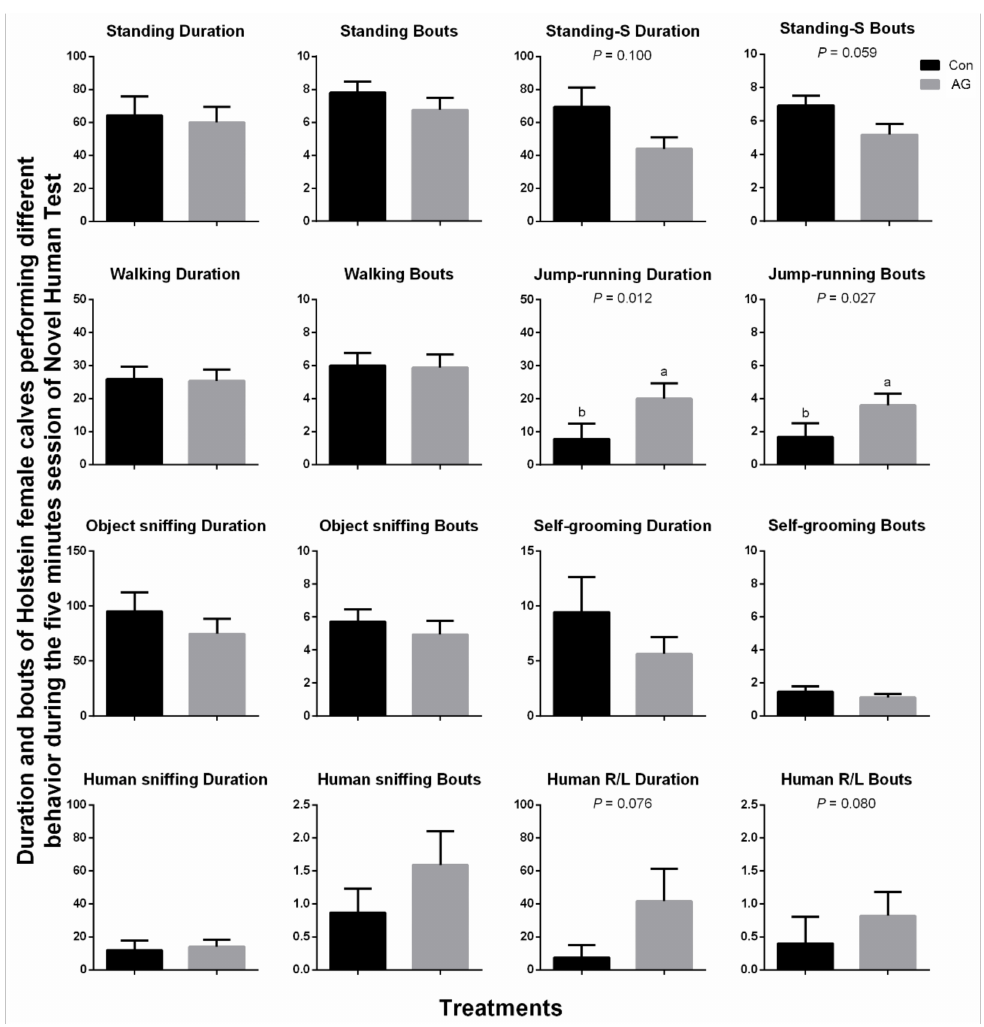
Figure 2. The e ff ect of artificial grooming on the behavior of Holstein female calves in the novel human test on day 7 (s). Standing-S = staring at the human while standing; Human R / L = human rubbing or licking. E ff ect direction is provided when the mean e ff ect is p ≤ 0.10. a,b Di ff erent superscript letters indicate a significant di ff erence between groups. Data are presented as means with standard error bars of SEM. Control group (Con), n = 16; Artificial grooming group (AG), n =